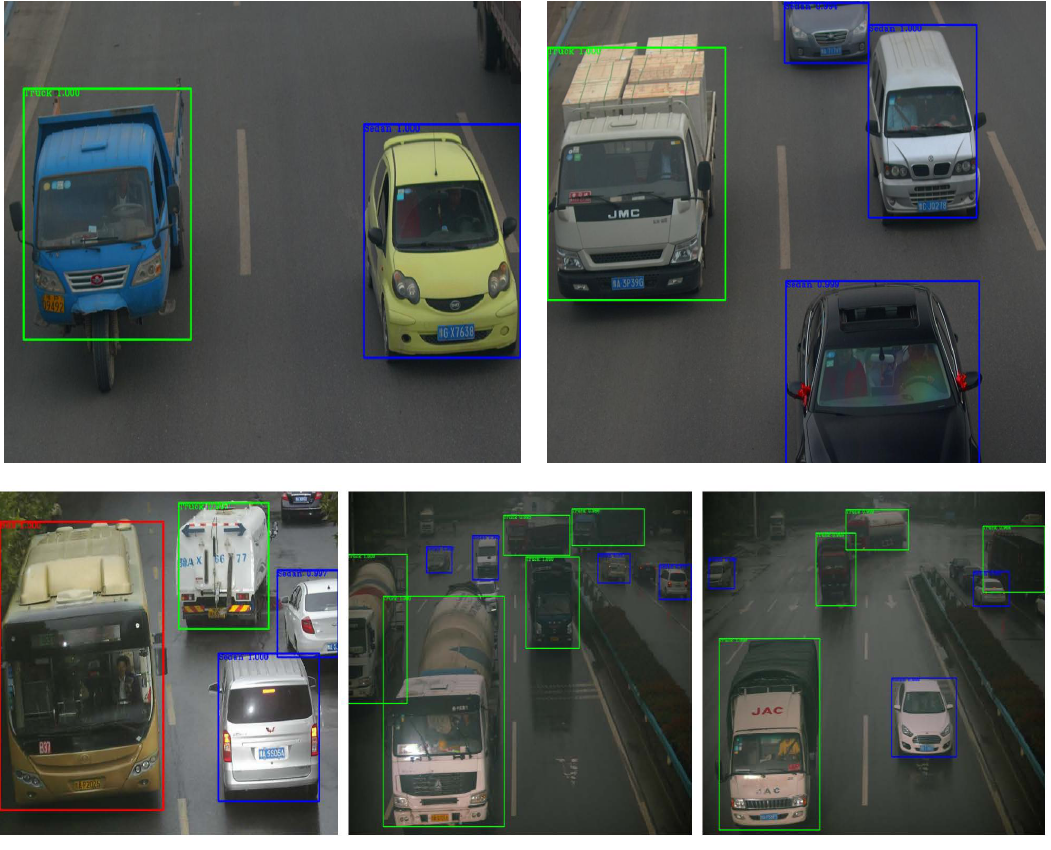
Figure 8. Effect of vehicle-type